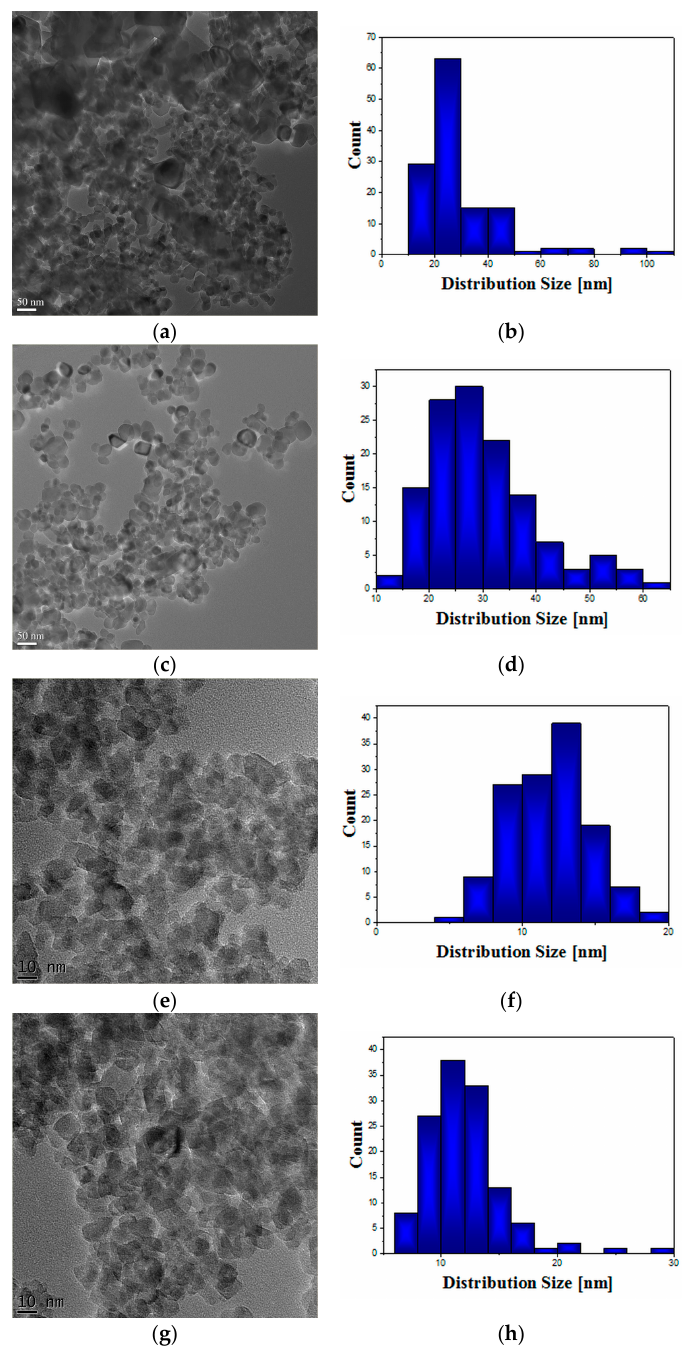
Figure 3. Transmission electron microscopy (TEM) images and particle distribution diagrams of the following samples: P25 ( a , b ); P25-1% Fe–N ( c , d ); TiO 2 -1% Fe–N (pH ~5.5) ( e , f ); and TiO 2 -1% Fe–N (pH ~8.5) ( g , h ).